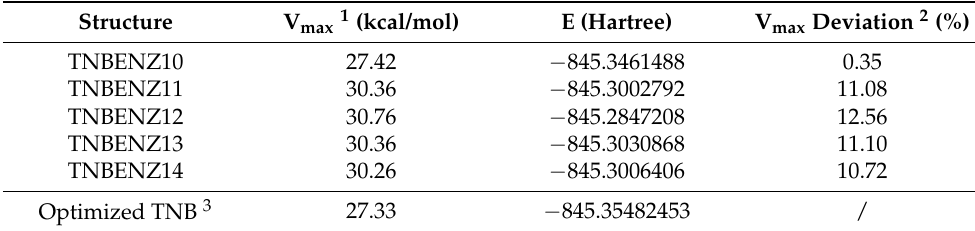
Table 1. Total energies, V max deviations, and V max values in critical points above the centers of nitroaromatic rings calculated for selected crystal structures containing TNB molecule.